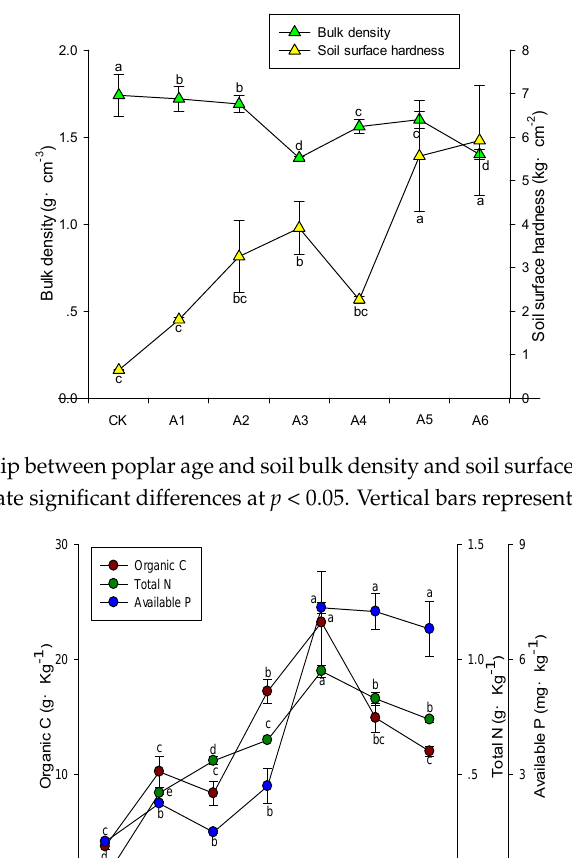
Figure 10. Relationship between poplar density and soil bulk density and soil surface hardness. Means with different letters indicate significant differences at p < 0.05. Vertical bars represent ± standard deviation.